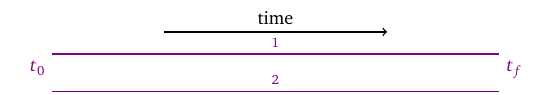
Figure 1: Contour for evolution of the density